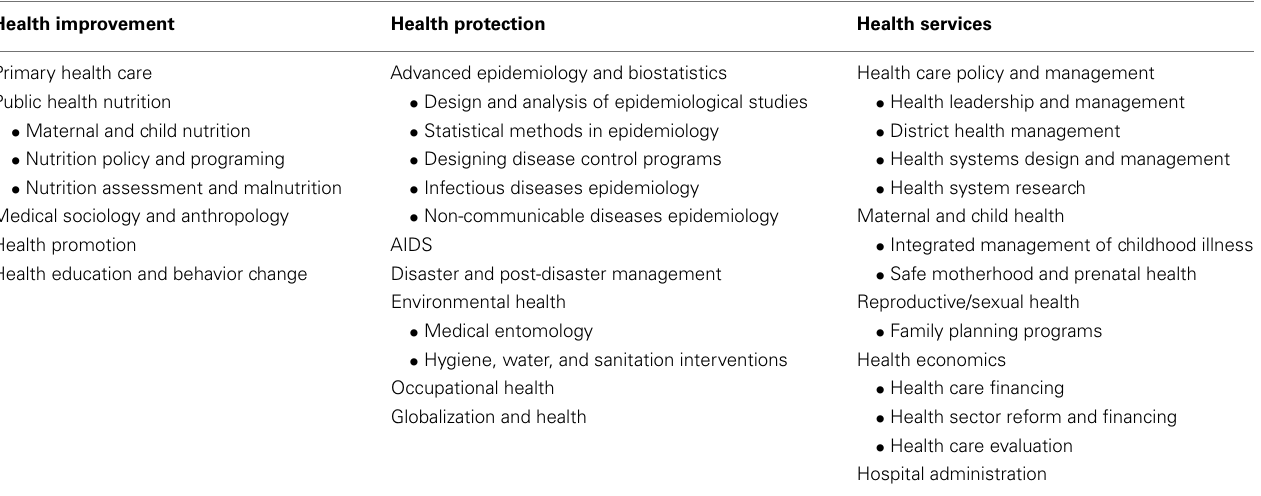
Table 1 | Examples of elective modules in each domain of public health practice